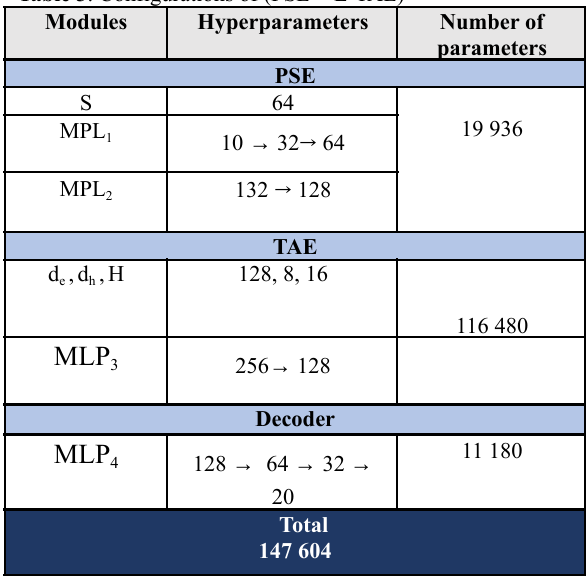
Table 3 . Configurations of (PSE + L-TAE)